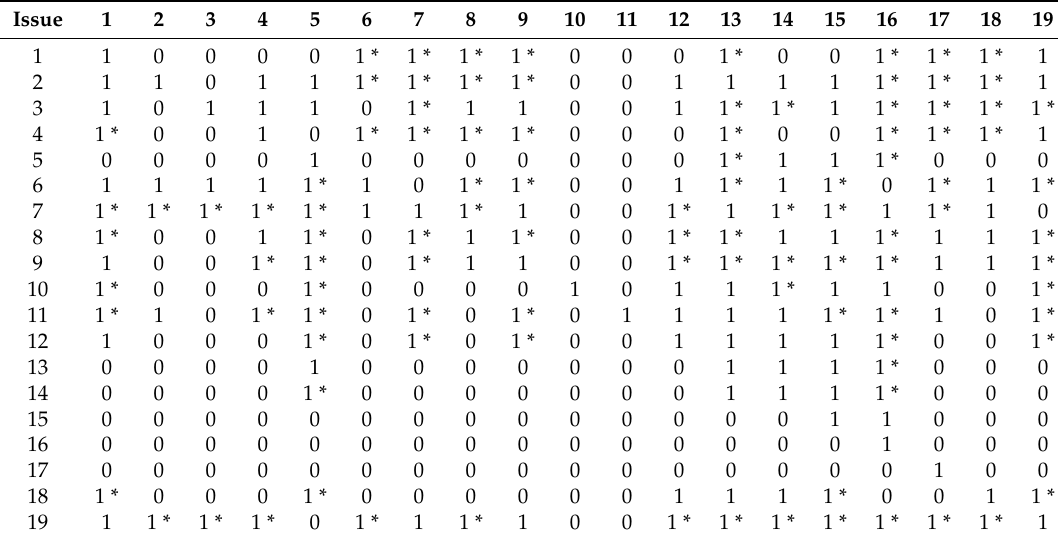
Table 4. Final Reachability